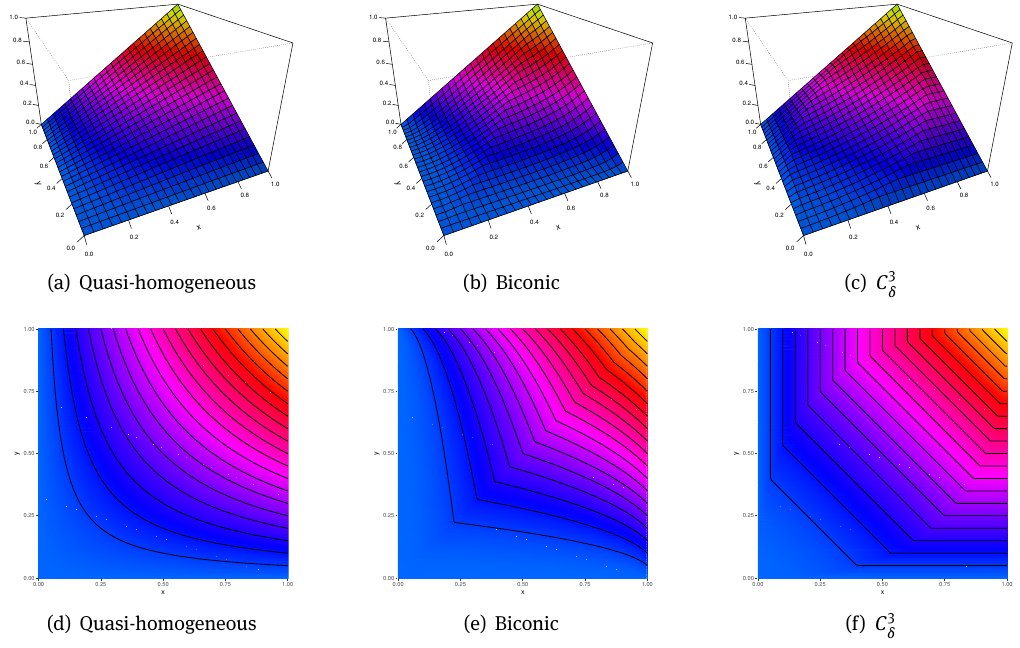
copulas with diagonal δ ( t ) = t 2 , and in the second row their δ